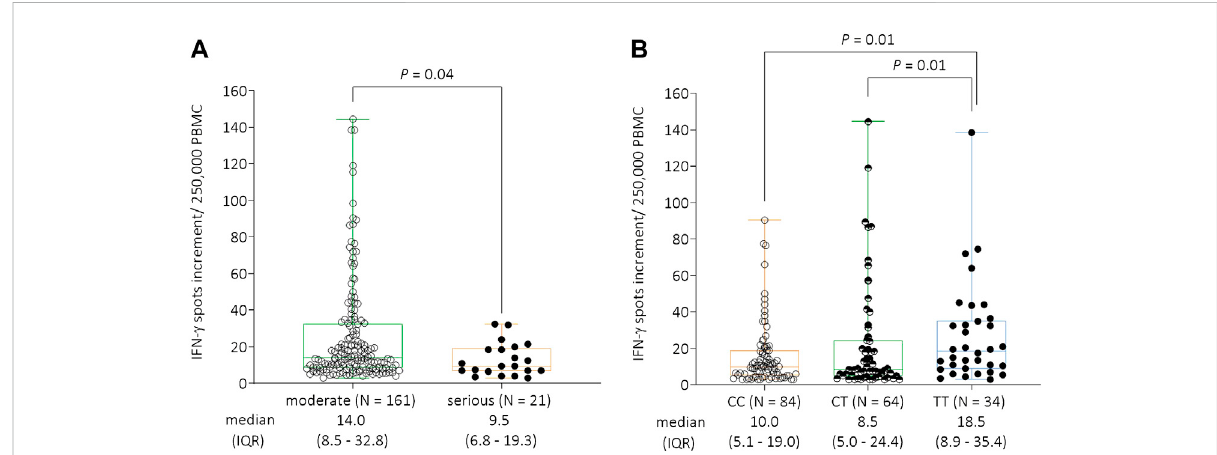
FIGURE 1 (A) IFN- γ ELISpot responses to S1/S2 protein of SARS-CoV-2 per 250,000 peripheral blood mononuclear cells strati fi ed by COVID-19 severity. Due to the low number of cases in the individual groups, patients from the categories “ mild ” and “ hospitalized ” were grouped together to the group “ moderate, ” whereasthepatientswith “ severe ” and “ fatal ” COVID-19wereconsolidatedtothegroup “ serious. ” Therewasasigni fi cantdeclineofIFN- γ spots increment comparing the “ serious ” ( N = 21, median = 9.5, and IQR = 6.8 – 19.3) to the “ moderate ” ( N = 161, median = 13.5, and IQR = 8.0 – 35.0)groups ( p = 0.04). (B) IFN- γ ELISpotresponses to S1/S2 protein of SARS-CoV-2 per 250,000 peripheral blood mononuclear cells strati fi ed by the GNB3 rs5443 genotype. Individuals with the TT genotype had signi fi cantly higher spots increment (median = 18.5, and IQR = 8.9 – 35.4) compared to CT (median = 8.5, IQR = 5.0 – 24.4, and p = 0.01) or CC genotype carriers (median = 10.0, IQR = 5.1 – 19.0, and p = 0.01). Abbreviations: IFN- γ = interferon gamma; PBMC = peripheral blood mononuclear cells; IQR = interquartile range.